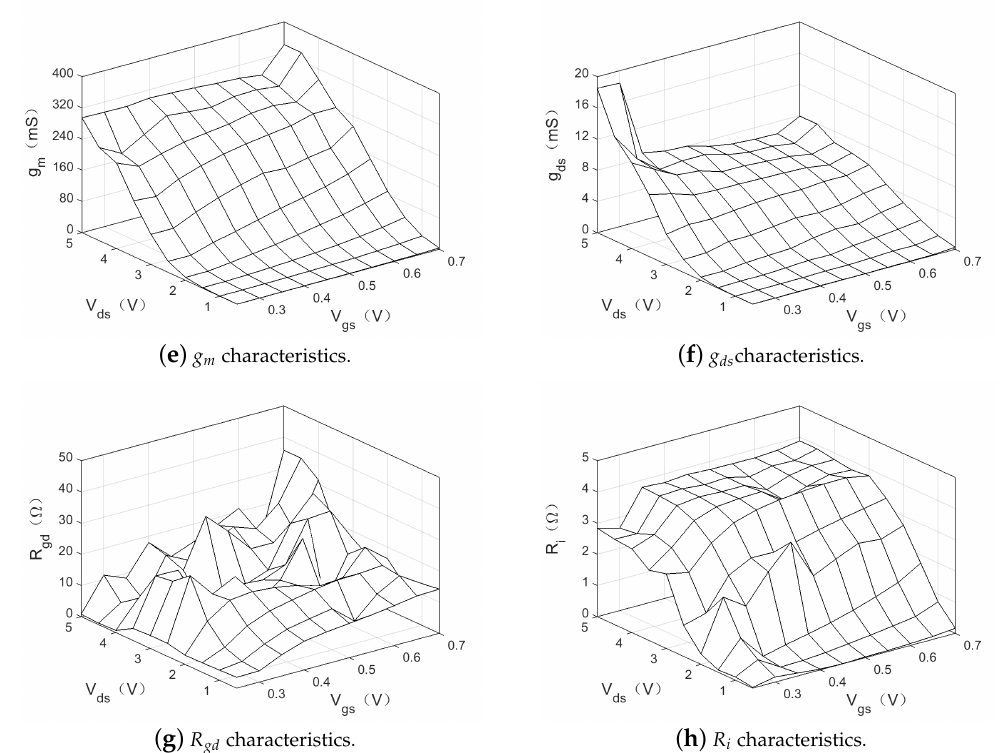
Figure 8. Intrinsic element characteristics of the small-signal equivalent circuit for pHEMT as a function of gate-to-source and drain-to-source voltage (V).